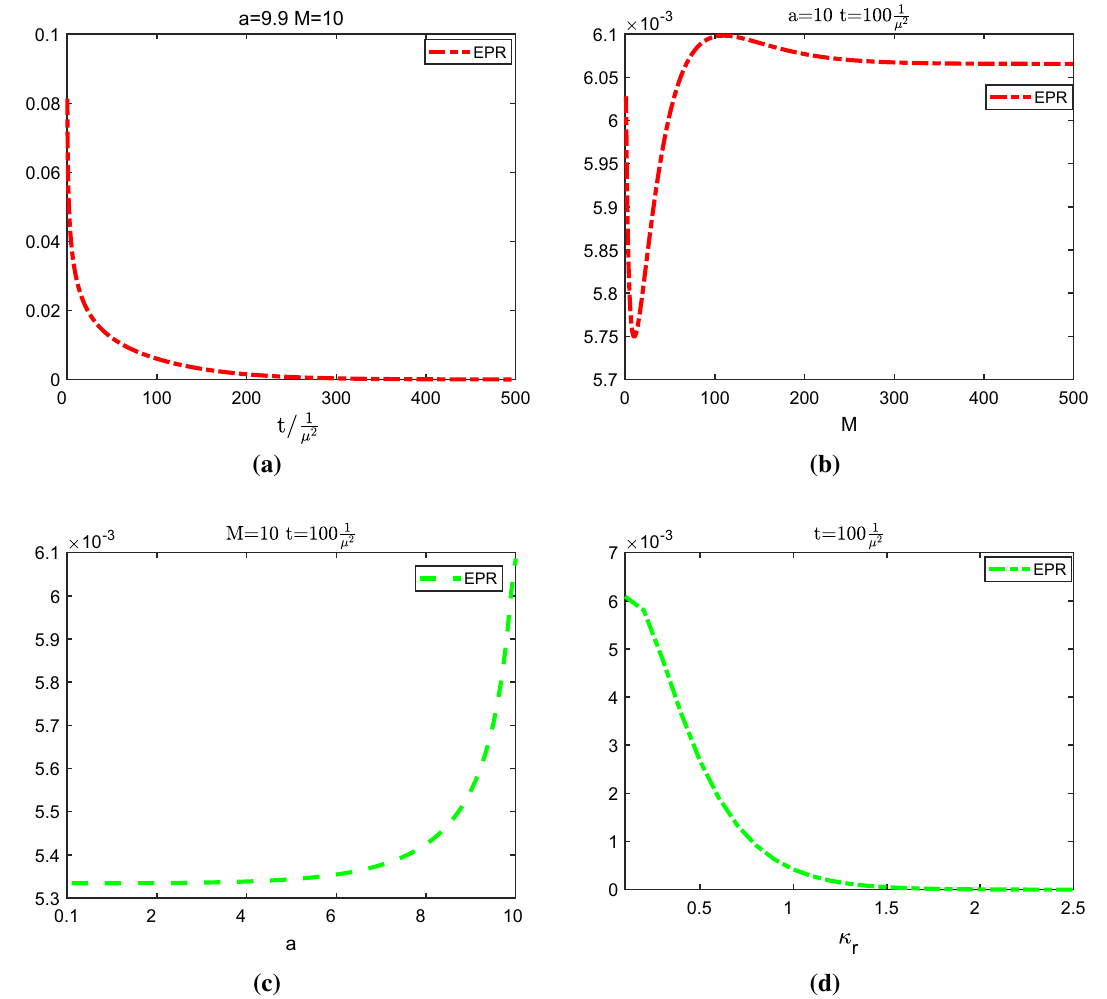
Fig. 8 a EPR at nonequilibrium state varies with time t when angular momentum a = 9 . 9 and the mass M = 10. b EPR vs. mass when a = 10 and t = 100 μ . c EPR vs. the angular momentum per mass when m = 10 and t = 100 μ 2 those in Fig.